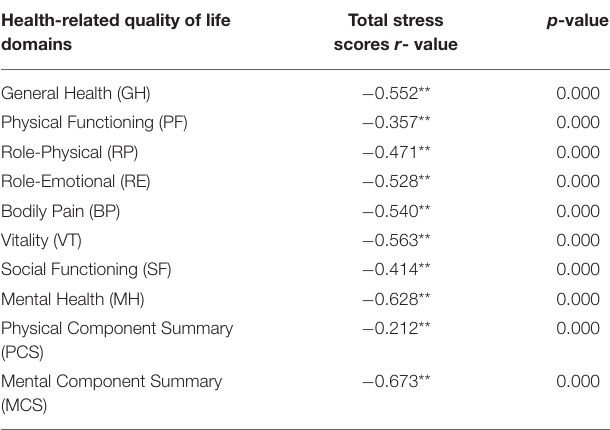
TABLE 5 | Correlation between perceived COVID − 19 total stress scores and HRQOL among the participants during the pandemic lockdowns ( N = 878). Health-related quality of life